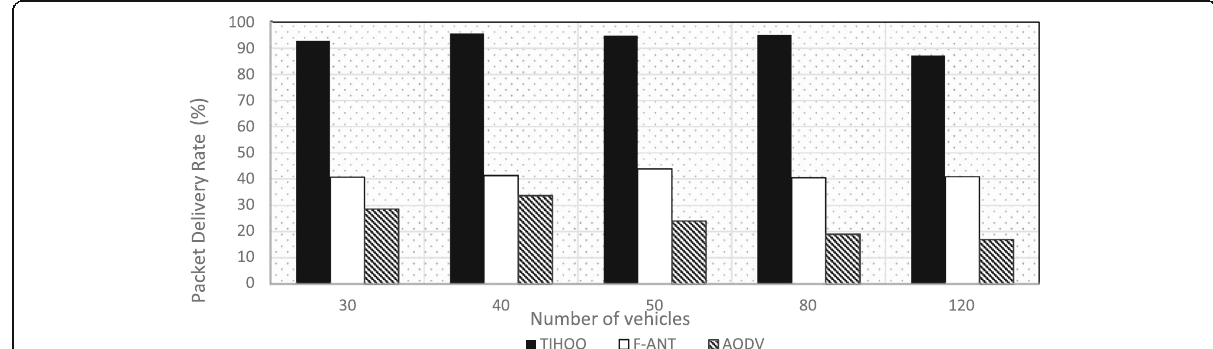
Fig. 6 Packet delivery ratio based on the number of vehicles. Comparison of the performance of TIHOO with that of F-ANT and AODV for packet delivery ratio. This improvement is due to the cuckoo search algorithm in the proposed protocol and the intelligent configuration of the fitness function parameters such as the reliability and the link lifetime which positively affect the data packet delivery rate via the selection of more stable routes as the optimal route. Simulation results show that TIHOO performs better than F-ANT and AODV in terms of